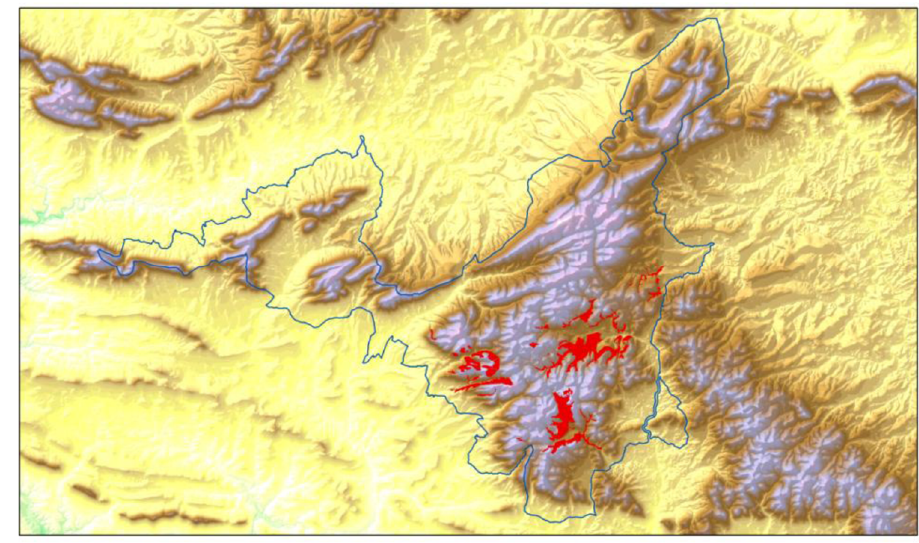
( c ) SCI: Sierra the Canalizos. Mapped associations (habitat). Red: 9230, 823022 Figure 1. ( a–c ) 9230 Oak woods with Quercus pyrenaica and oak woods with Quercus robur and Quercus pyrenaica in the north-west Iberian Peninsula. Longitude 4°36′37″ W, latitude 38°56′38″ N (Saceruela). 823022 Arbuto unedonis-Quercetum pyrenaicae (Rivas Goday in Rivas Goday, Esteve, Galiano, Rigual & Rivas-Martínez 1960) Rivas-Martínez 1987. (Sierra de Canalizos, red polygons. Sierra Morena, blue polygons). 823029 Sorbo torminalis - Quercetum pyrenaicae Rivas Goday ex Rivas-Martínez 1987. (Sierra Morena, red polygons). The map shows deciduous forests of Quercus pyrenaica in two plant associations in sites of community interest.